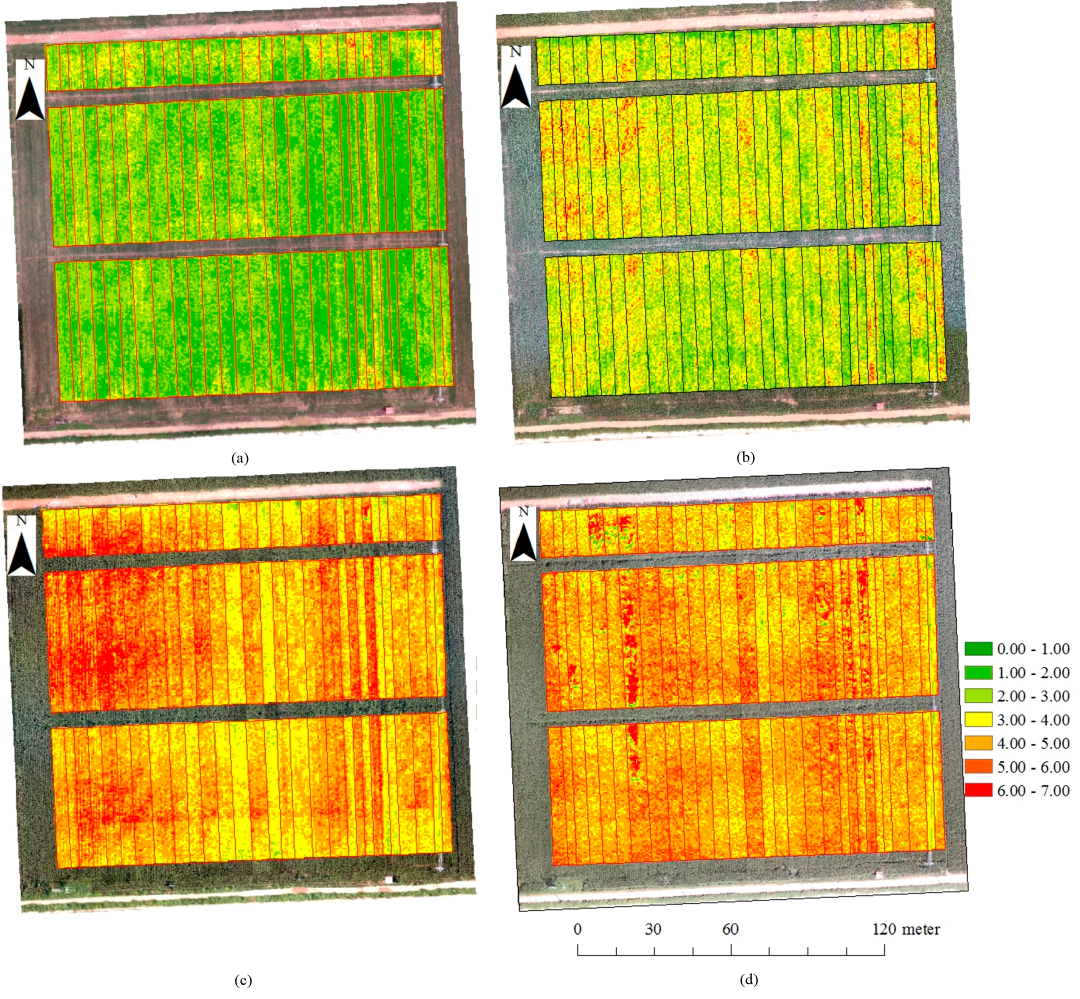
Figure 8. The retrieved LAI on ( a ) 15 July (stem elongation stage), ( b ) 26 July (the flare opening stage), ( c ) 11 August (the heading stage), and ( d ) 4 September (the milking